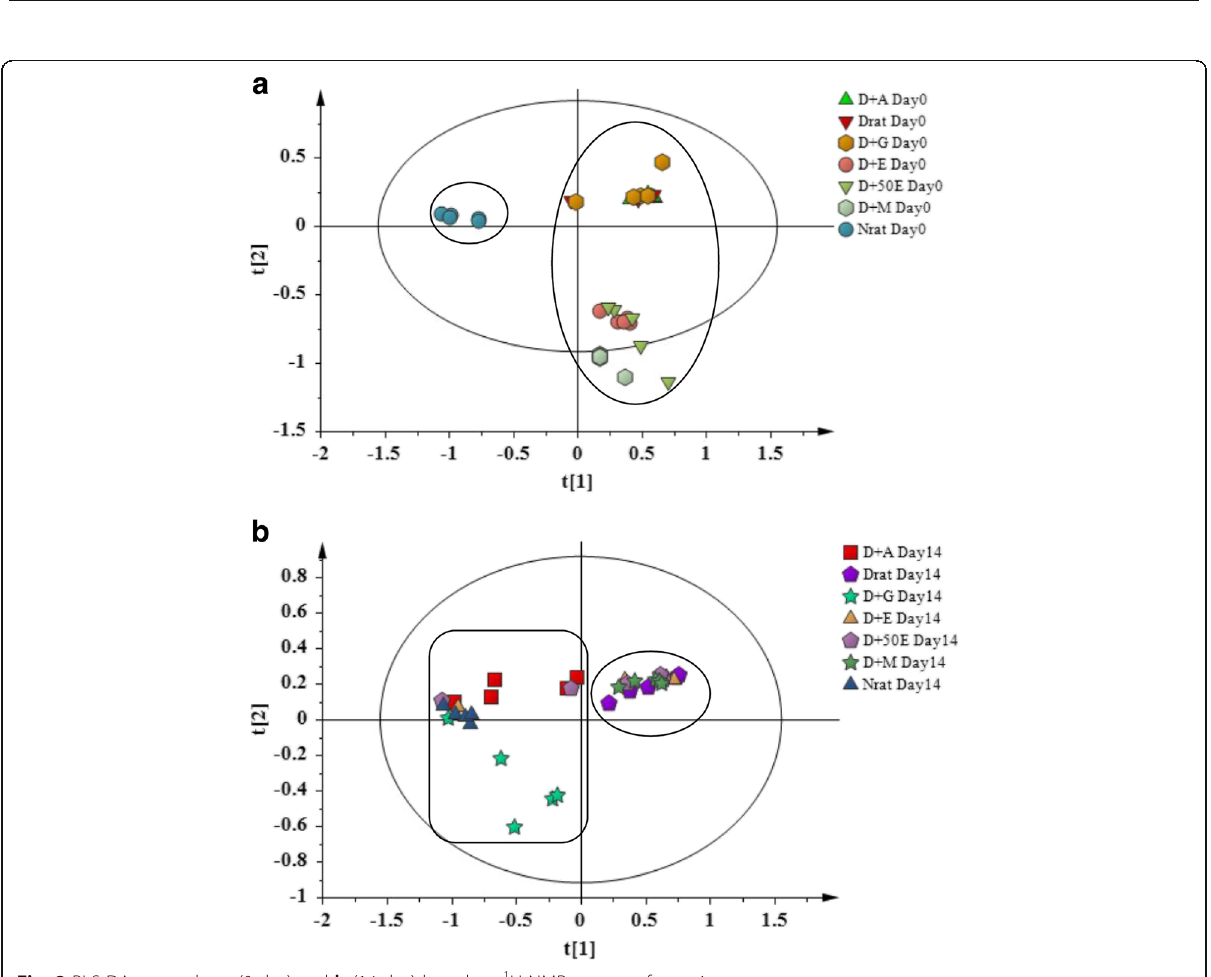
Fig. 2 PLS-DA score plot a (0 day) and b (14 day) based on 1 H NMR spectra of rat